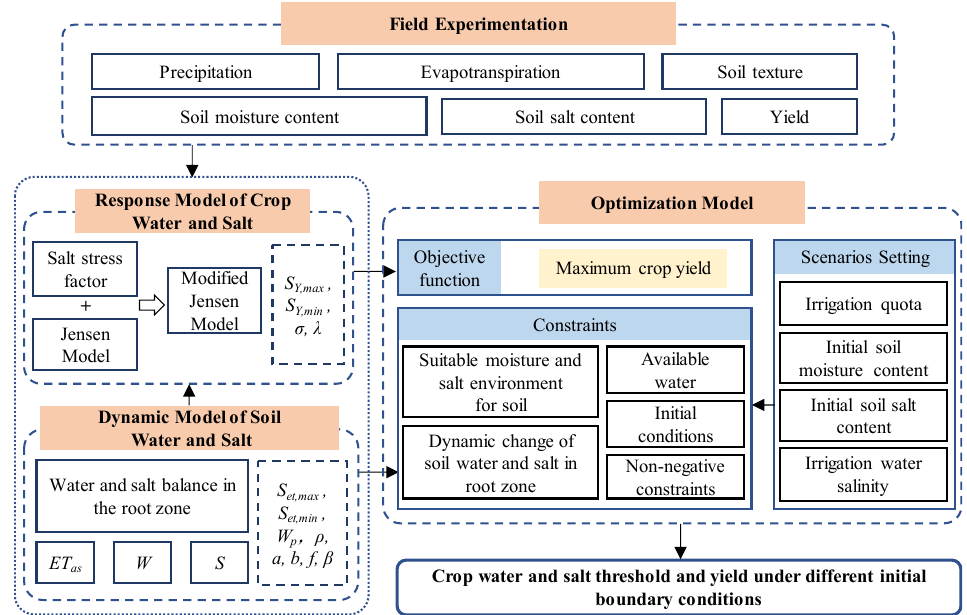
Figure 1. Outline of the study. Note: the dotted boxes represent the parameters in the model that need to be calibrated by the experimental data. S Y,max and S Y,min are the critical and maximum soil salinity which affect the yield at different growth stages, respectively; S et,max and S et, min are the critical and maximum soil salinity which affect ET at different growth stages, respectively; ETas are the actual evapotranspiration; W and S are soil moisture content and soil salt content, respectively; W p is the critical water content at different growth stage; a and b are exchange coefficients of capillary rise and drainage, respectively; f and β are the leaching and capillary rise coefficient.